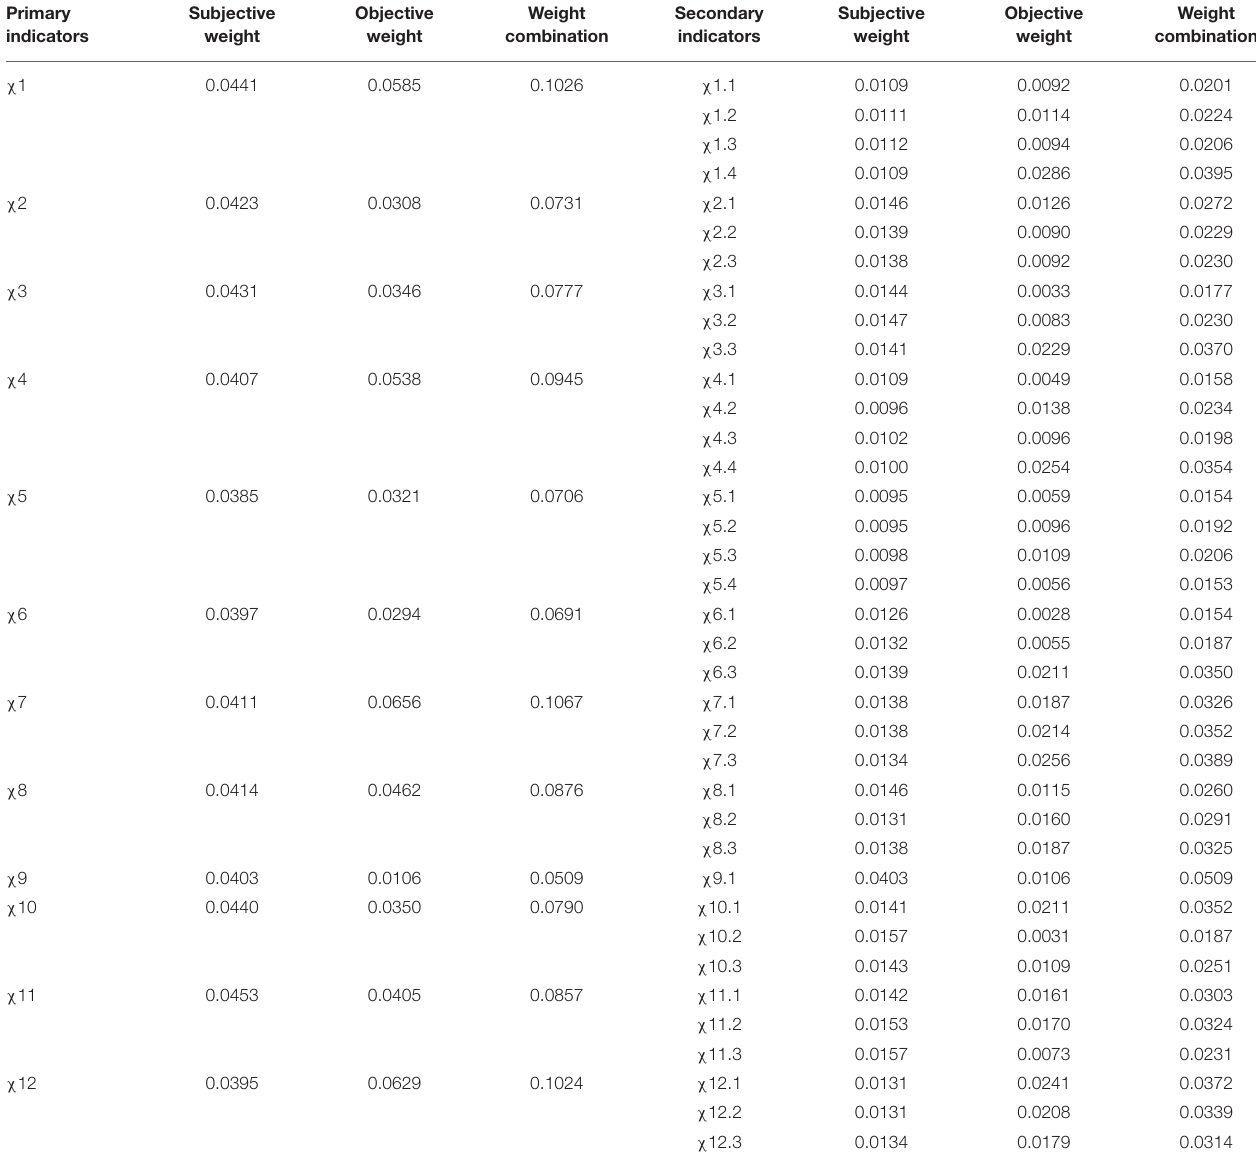
TABLE 3 | Comprehensive evaluation of indicator weights for pathogenic microbial laboratory management. Primary